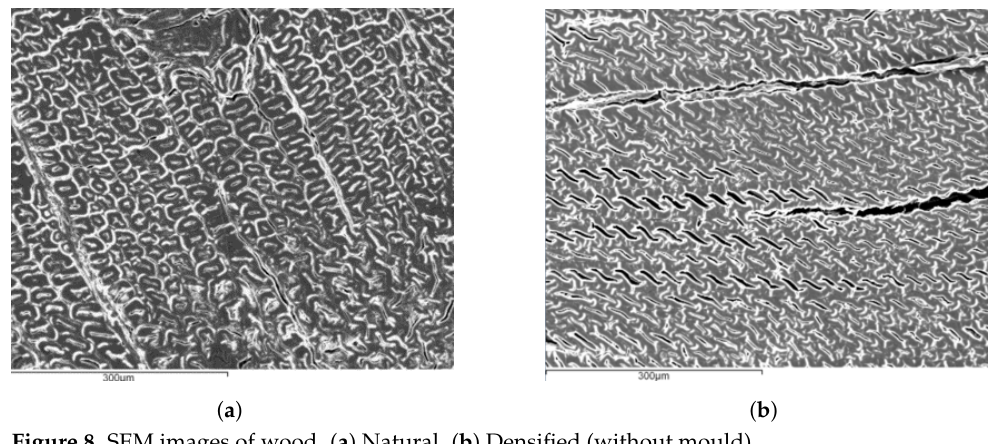
Figure 8. SEM images of wood. ( a ) Natural. ( b ) Densified (without mould).